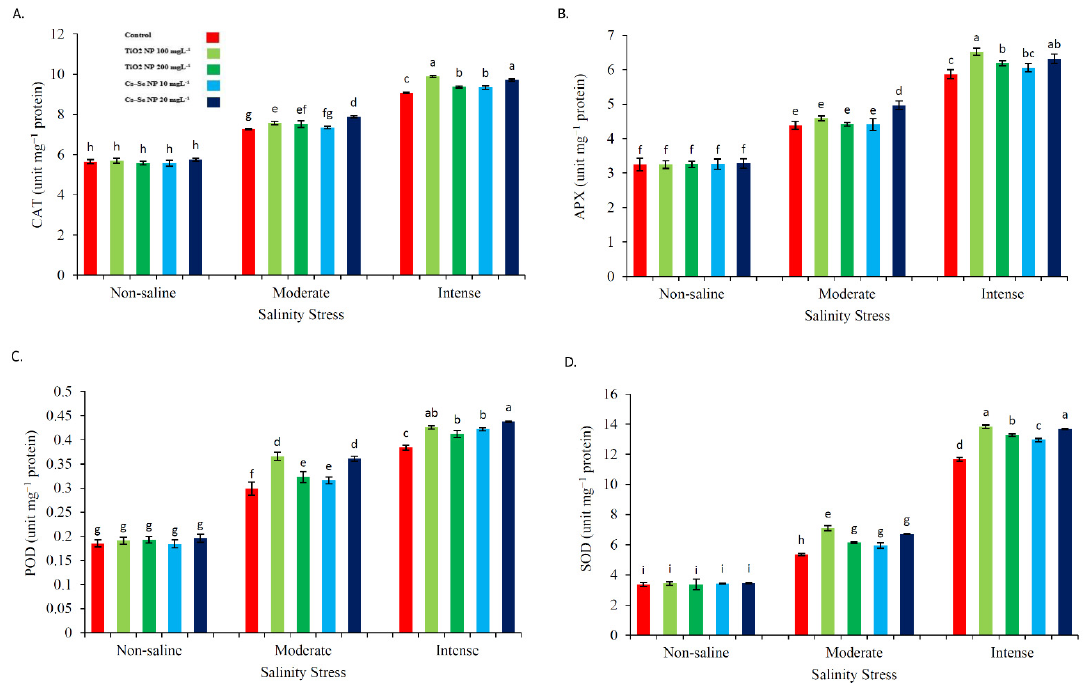
Figure 4. Effect of different concentrations of Cs–Se NPs and TiO 2 NPs on the CAT ( A ), APX ( B ), POD ( C ), and SOD ( D ) enzyme activities of stevia ( Stevia rebaudiana Bertoni) leaves under salinity stress. Data are the average of 3 repetitions ± standard error. Different letters indicate significantly different values according to Duncan’s post hoc analysis at p < 0.05.